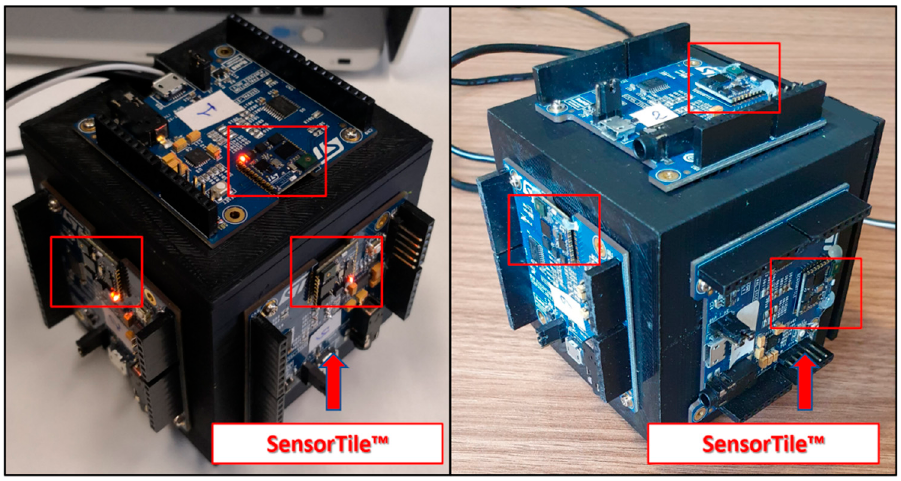
Figure 5. Prototype developed.